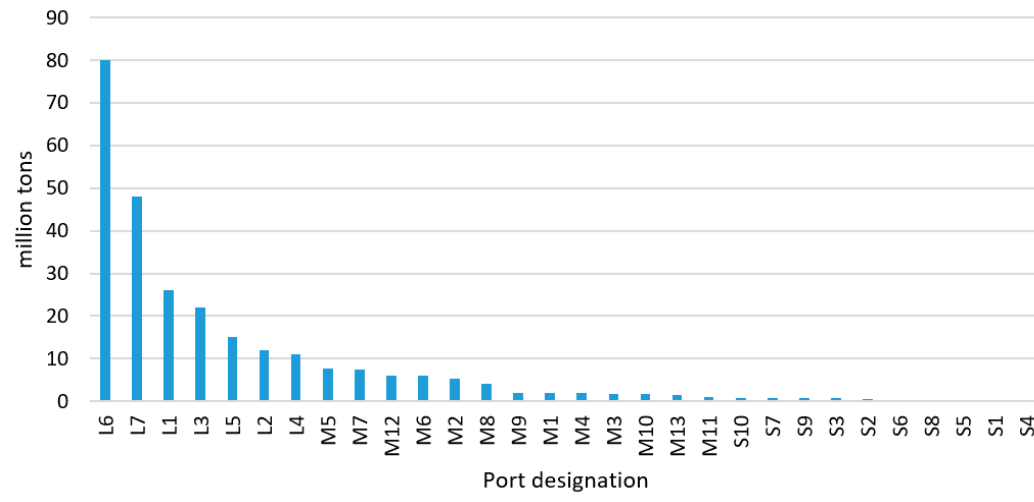
Figure 7. Ranking of analysed ports’ annual turnover.